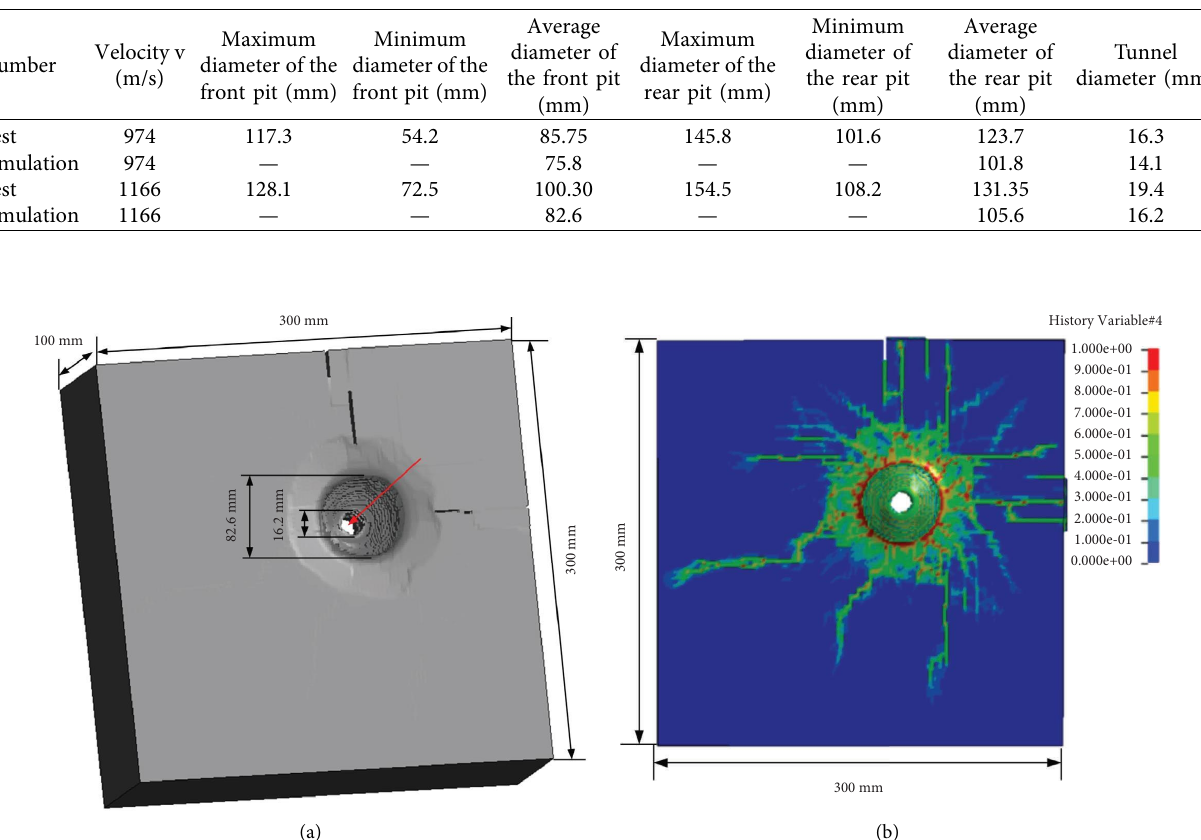
Figure 6: Front and back of target plate damage with a fragment velocity of 1166m/s. Table 6: Comparison of damage data between the test and simulation target.